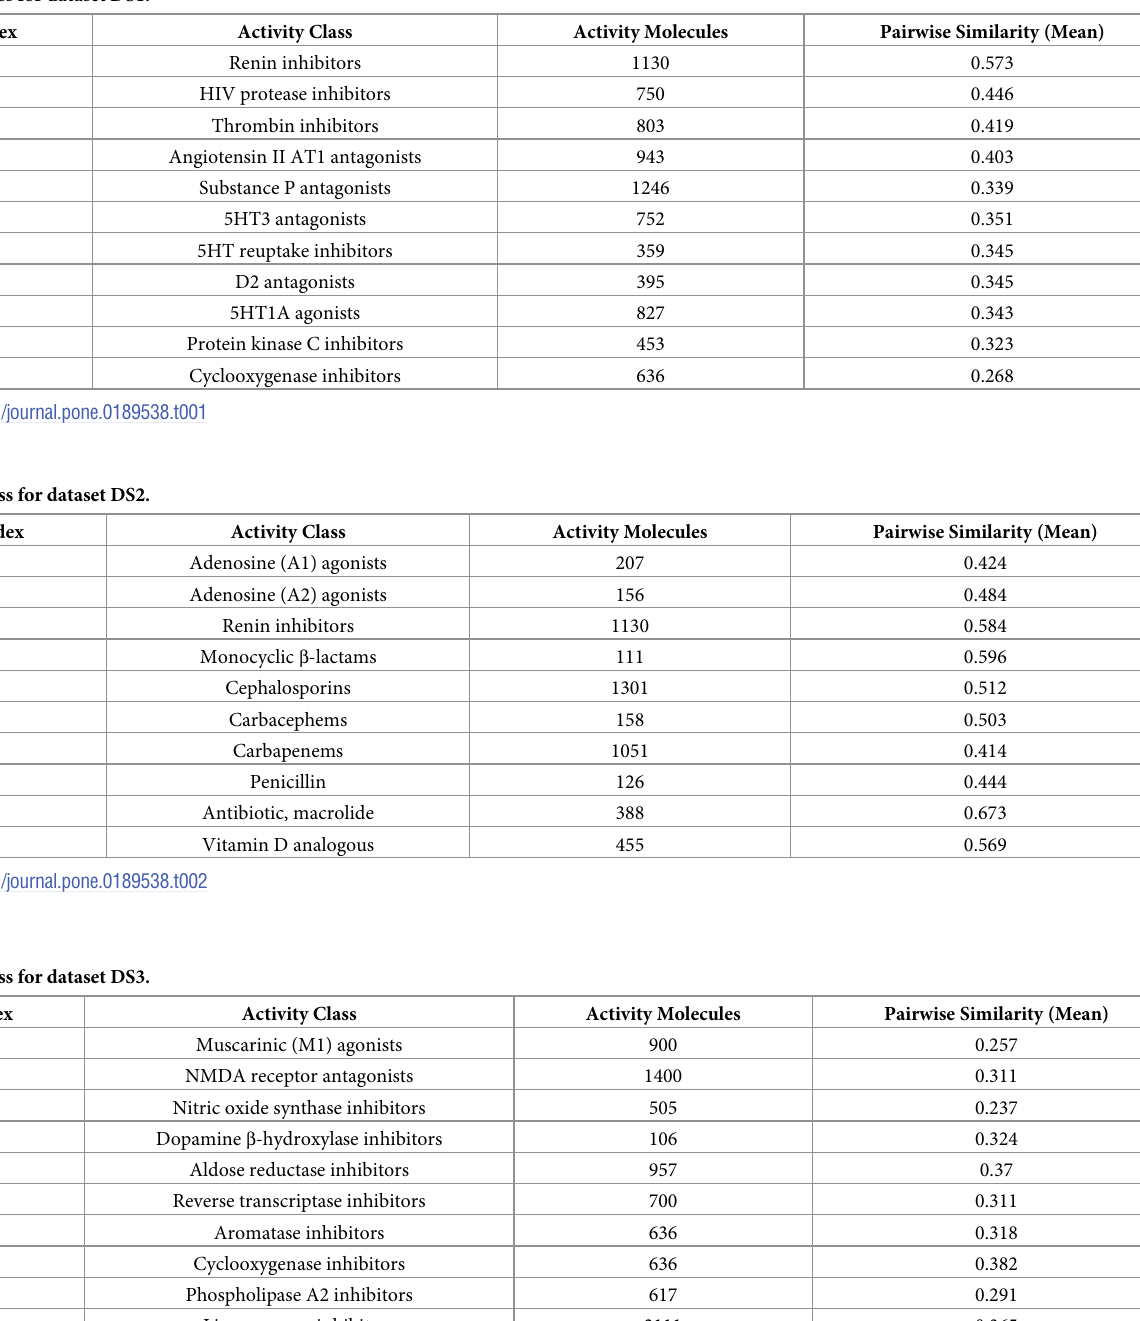
Table 1. Activity class for dataset DS1.